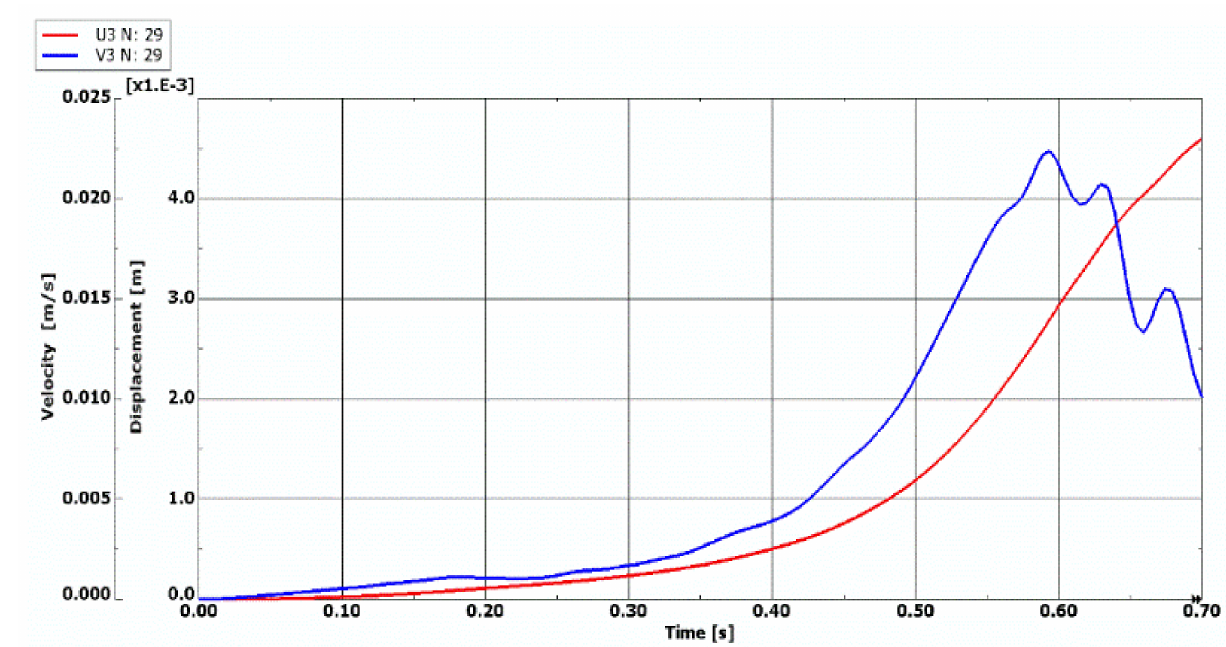
Figure 11. Time histories of deflection and velocity of deflection of damaged FEM plate model with all fibers cracked.